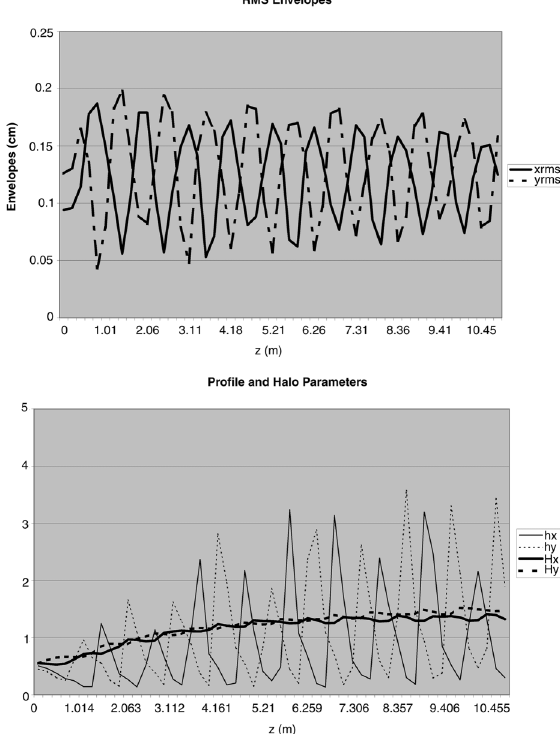
2. rms envelopes and halo parameters for the quadru- pole mismatch.